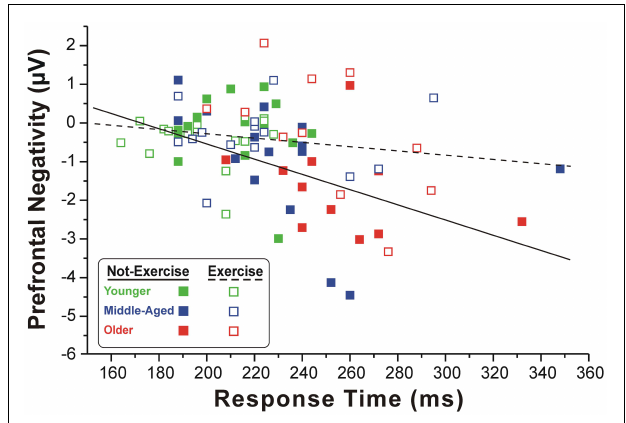
participants .The dashed line represents the linear fit of the exercise cohort, whereas the solid line refers to the not-exercise cohort. Only the former is significant, showing that larger is the PFC activity and slower is the RT.